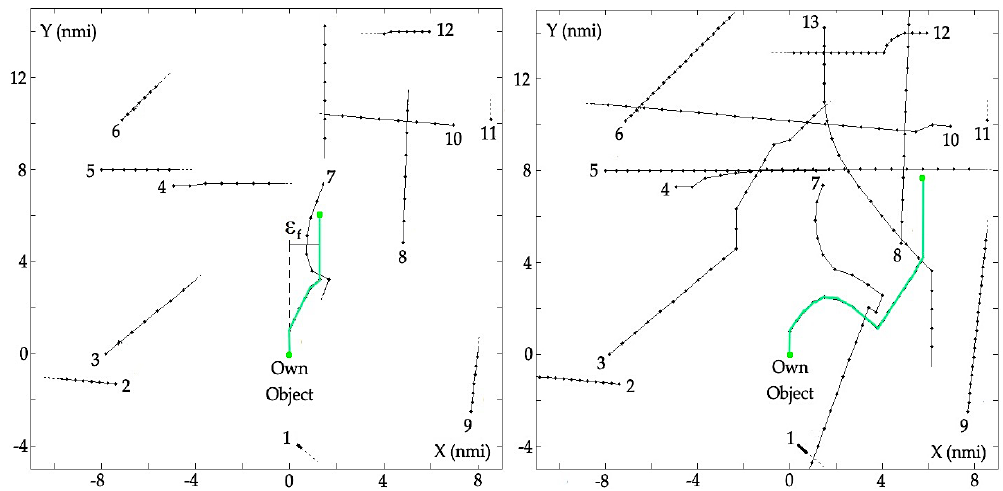
= f = = 5.8 nmi. f f = 5.8 nmi. f